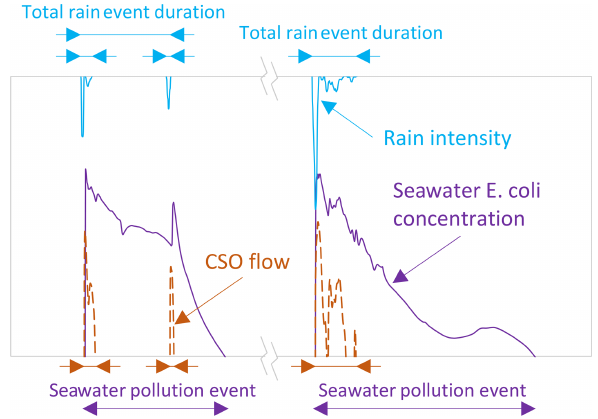
Figure 2. Definition of total rain event duration and seawater pollu- tion